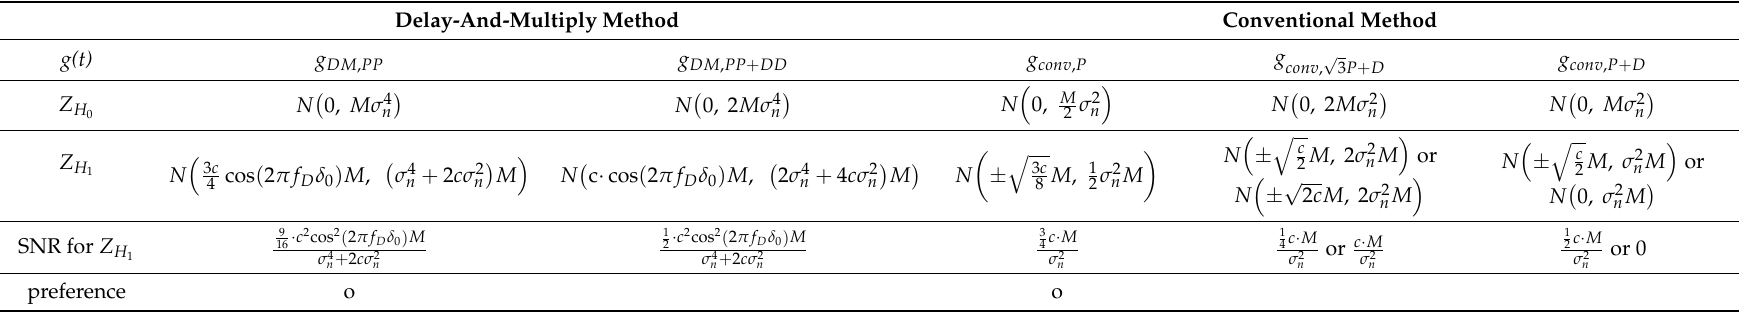
Table 1. Comparison of the performance between the DM method and the conventional